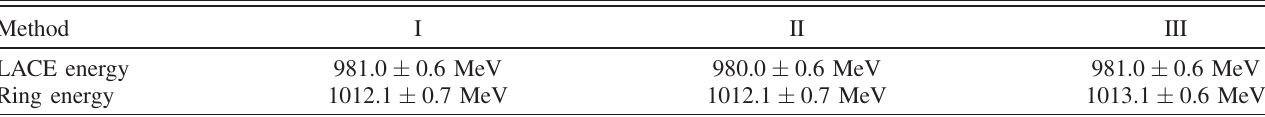
TABLE II. Method I denotes measured energy; Method II denotes energy from TOF calculations using ring-calibrated phase offsets; and Method III denotes energy from TOF calculations using LACE-calibrated phase offsets. LACE energy refers to the energy of H − , and ring energy that of bare proton, during the respective experiments described in Sec. II and Sec. III. TOF velocities and their errors are calculated using Eq. (21) and (A12) respectively — conversion from velocities to energies is trivial. Method I LACE